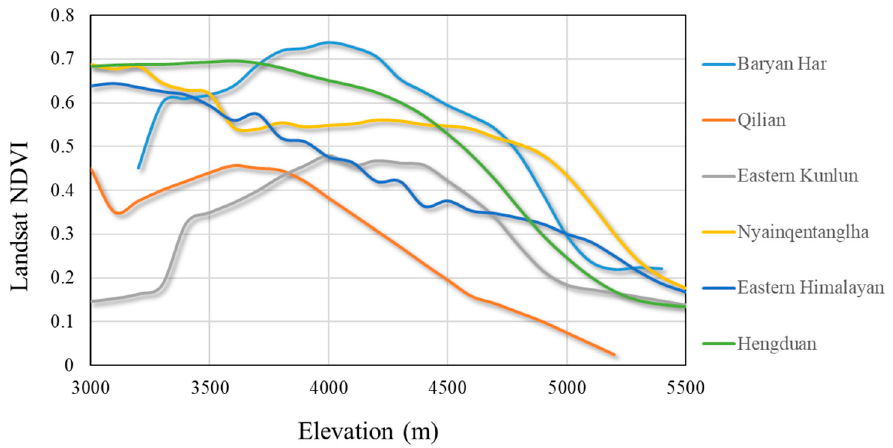
Figure 4. The change patterns of the averaged multiyear normalized difference vegetation index (NDVI) along the elevation bins in the six mountainous regions.